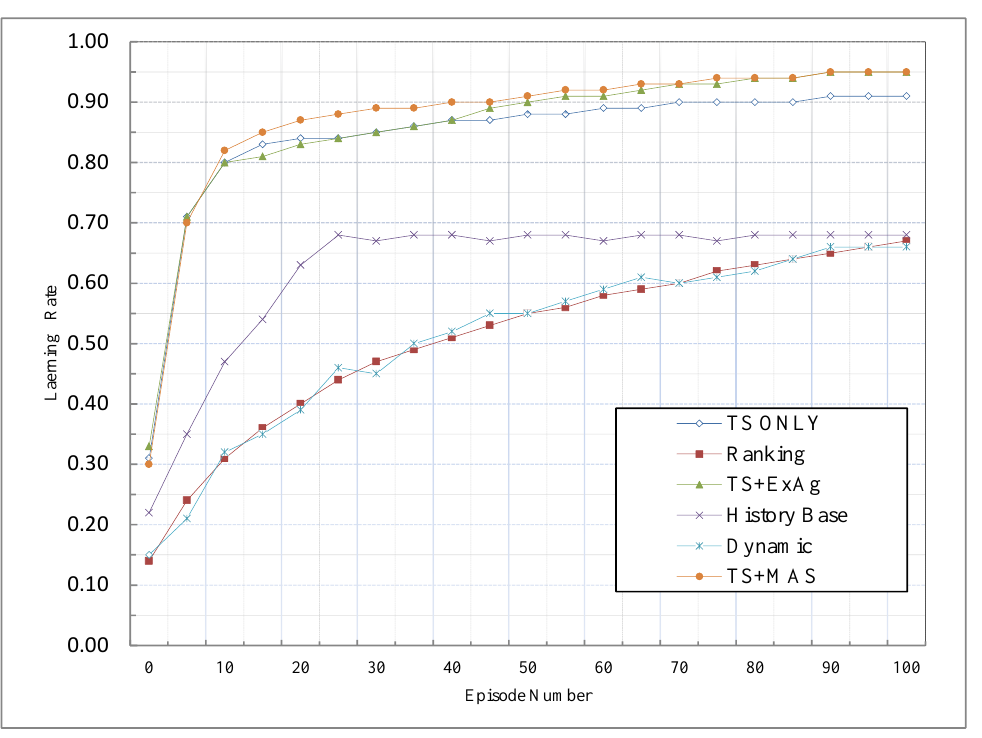
Figure 3. Comparison of MCA methods based on the group learning rate